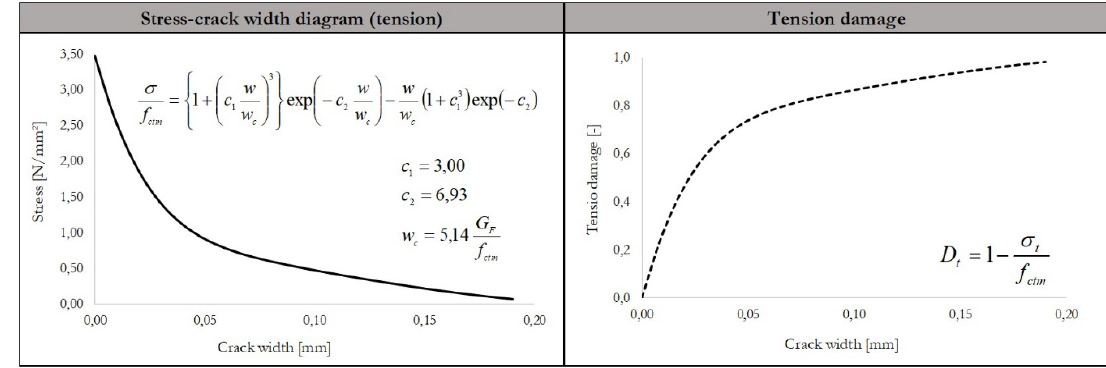
Figure 11. Material model for tension.